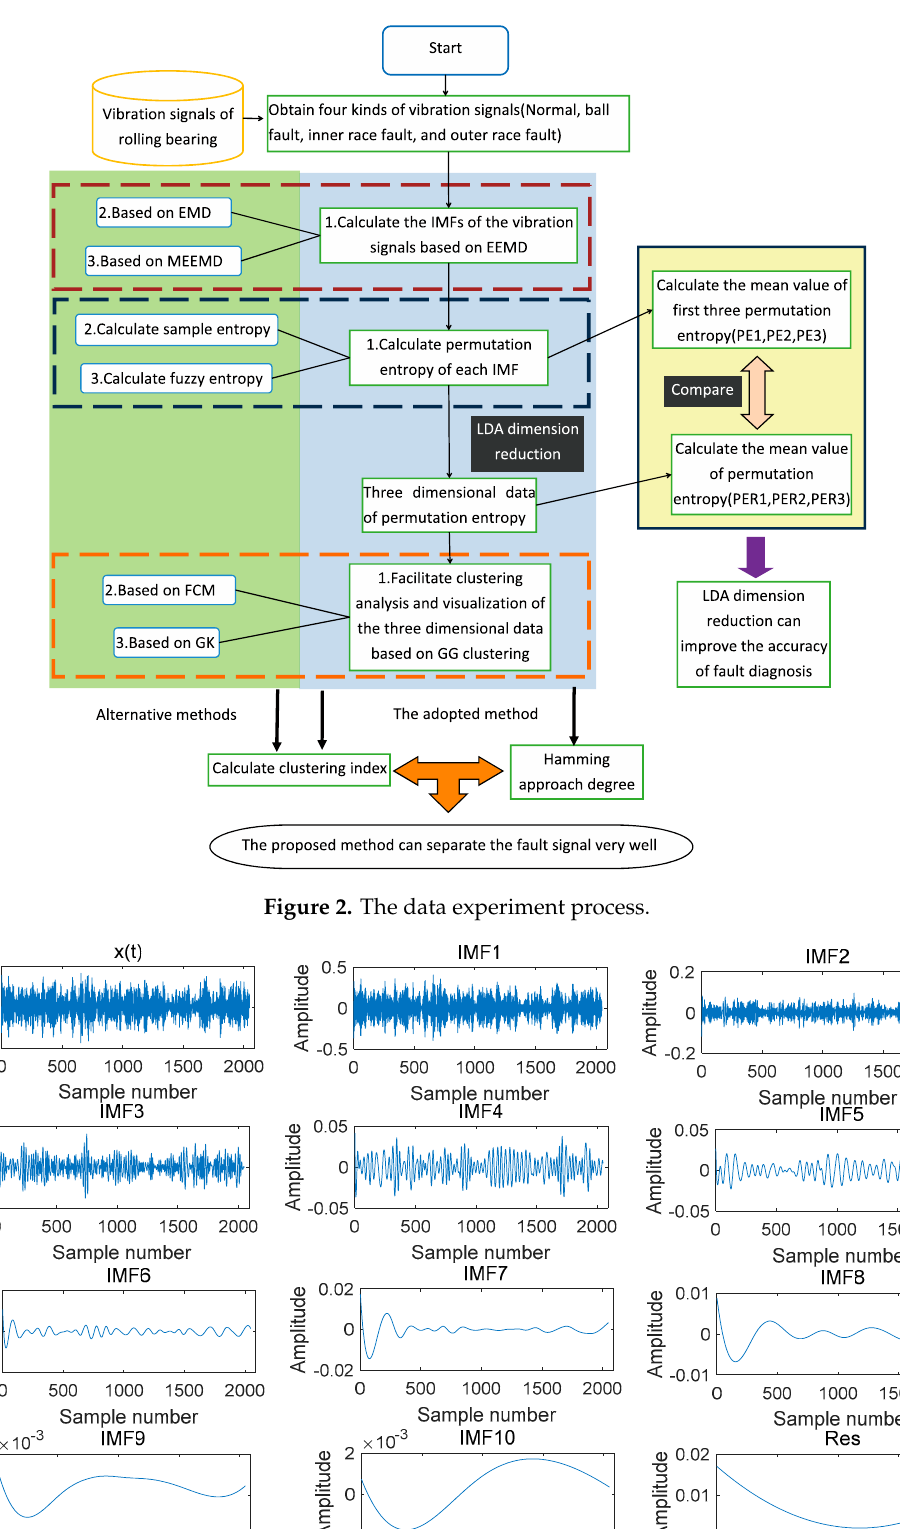
Figure 3. The intrinsic mode function( IMF) components of the vibration signals.